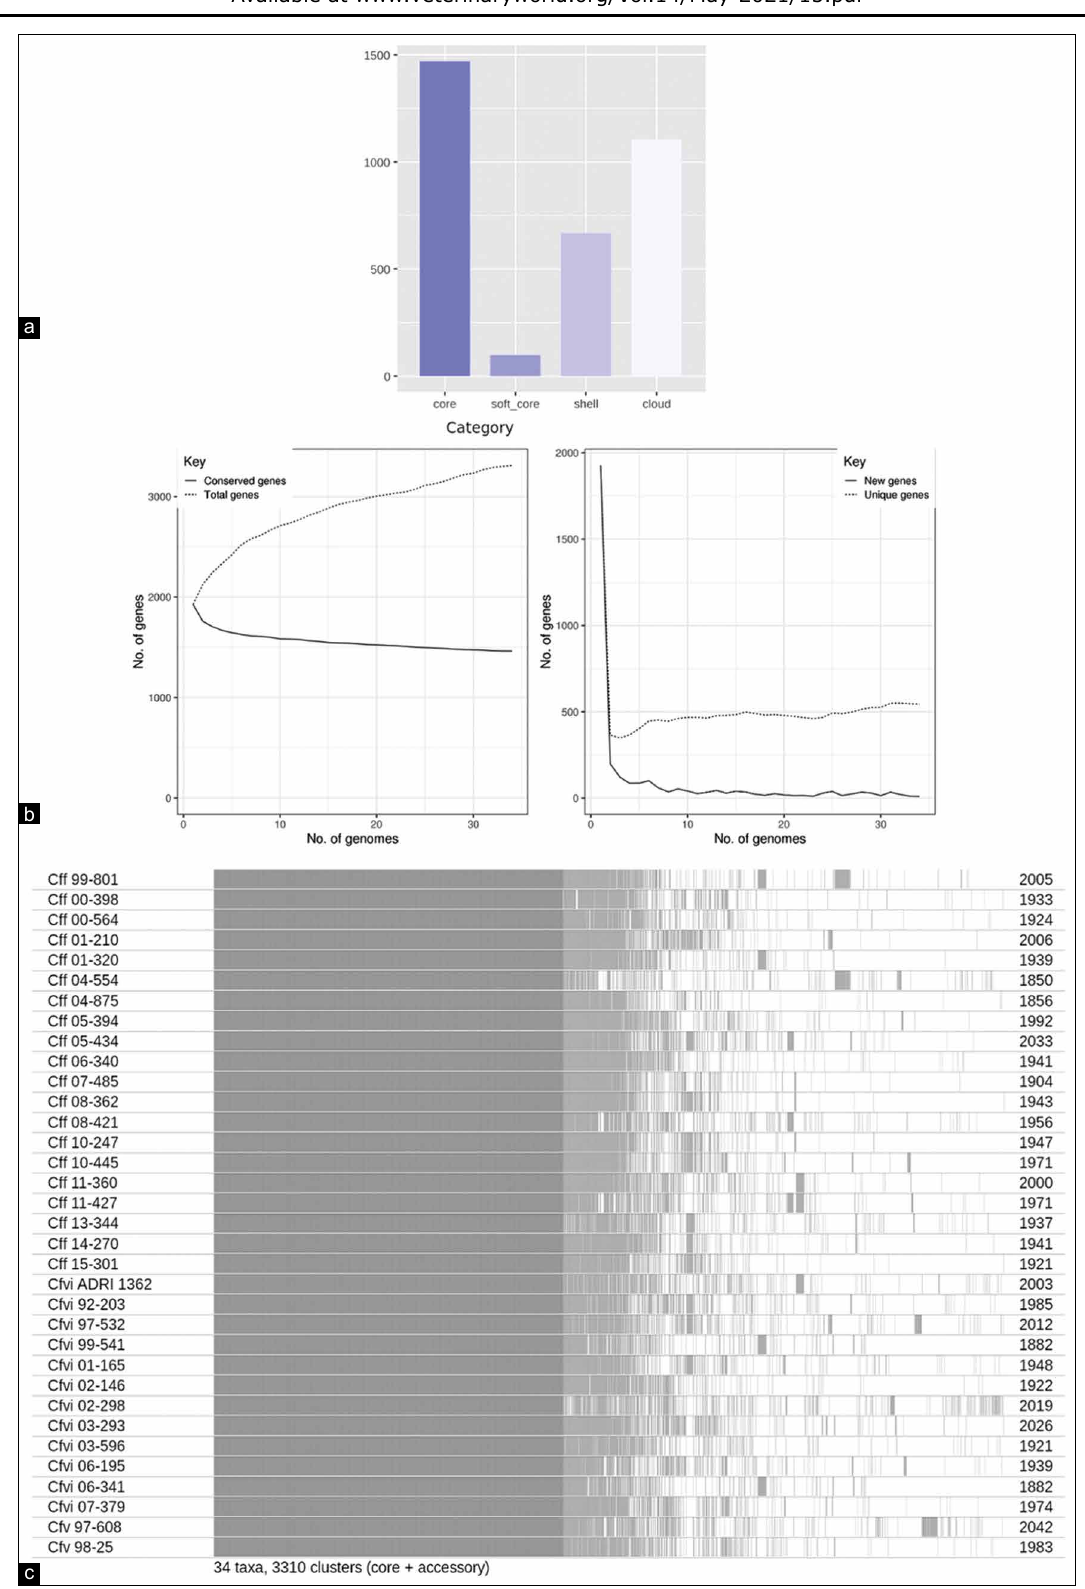
Figure-1: The pangenome of Argentine Campylobacter fetus strains. (a) Visualization of the number of genes according to the different categories by Roary [12]. (b) Gene accumulation curve contrasting conserved homologous genes vs . total genes in 34 C. fetus genomes (left). The curves represent the adjustment of the pangenome size as individual genomes are added (right). (c) Presence-absence profile of genes in each strain. To the right, the number of genes belonging to each